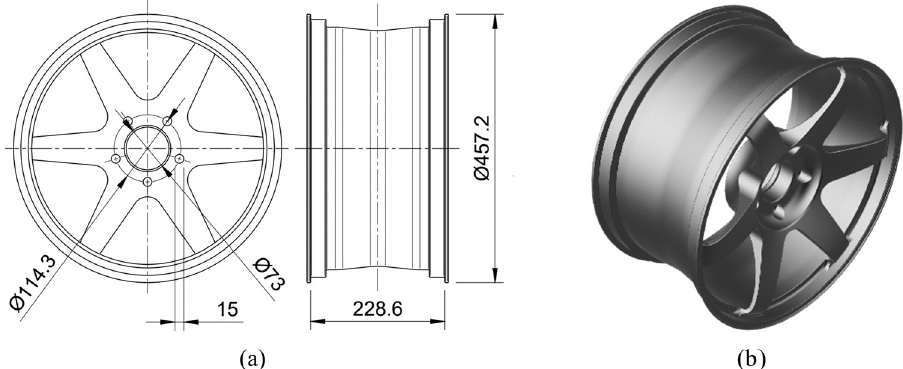
Figure 3: ( a ) Rim wheel design in 2D and ( b ) rim wheel in 3D. All sizes are in